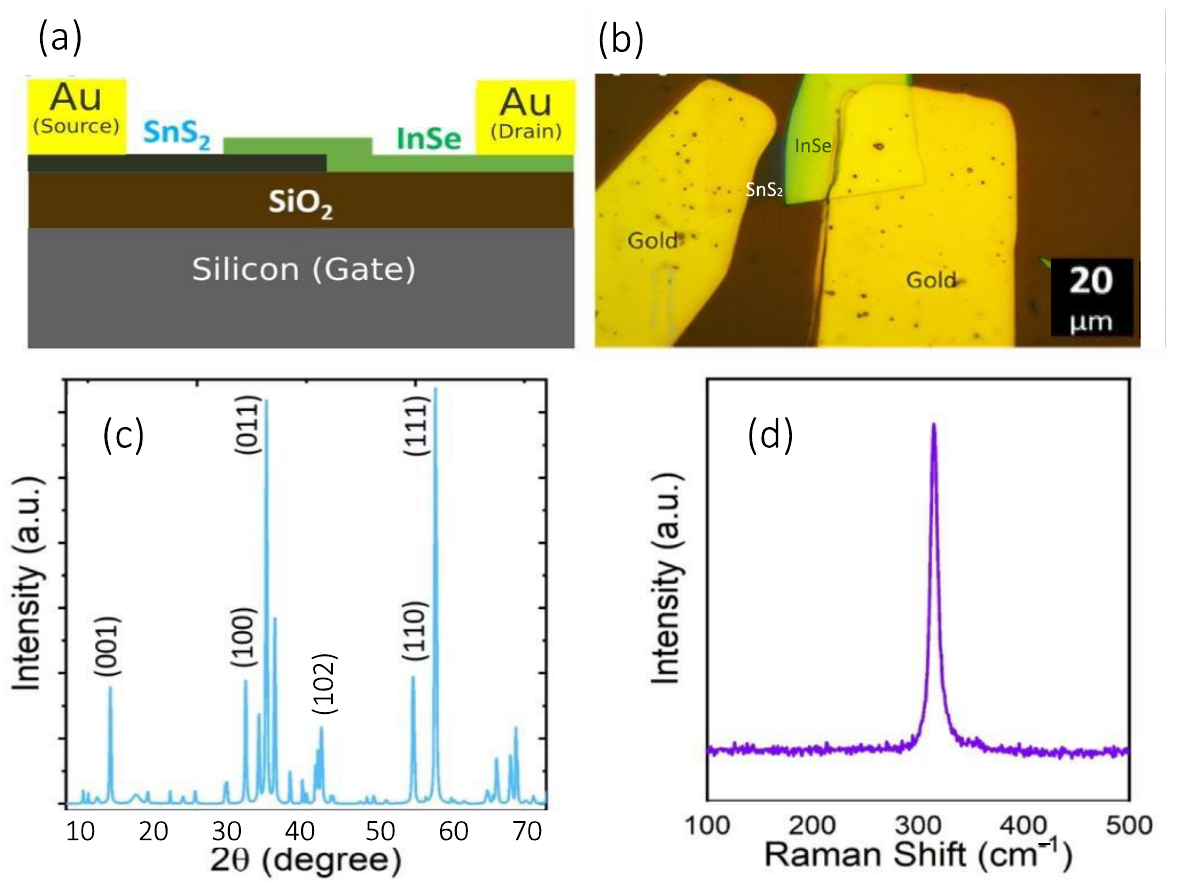
Figure 1. ( a ) Schematic of SnS 2 /InSe photodetector. ( b ) Optical microscope image of the fabricated device. ( c ) XRD spectrum of the SnS 2 Crystal. ( d ) Raman Spectrum of the SnS 2 layer.